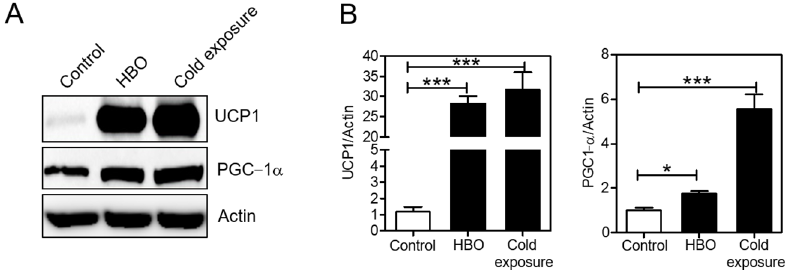
Figure 3. Effect of HBO on the expression of BAT markers. ( A ) Expression of a key set of brown fat marker genes (UCP1 and PGC − 1α) was confirmed by immunoblot. ( B ) Quantification of protein levels. Actin was used as a loading control for protein expression. Values are shown as ± S.E.M * p < 0.05, *** p < 0.001 compared to control ( n = 3 per each condition).